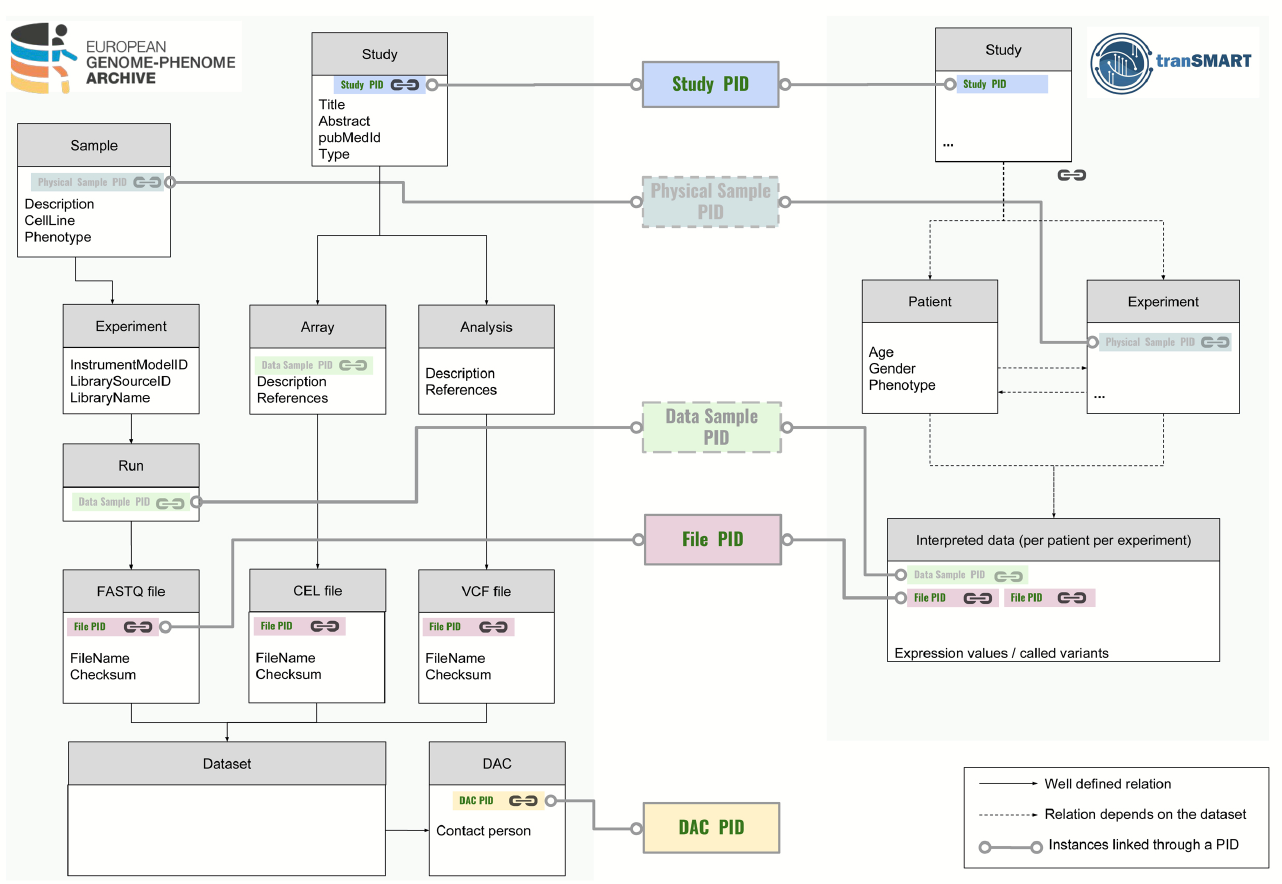
Figure 5. Suggested usage of persistent identifiers to link concepts between the data models of EGA and tranSMART. The data model of EGA differs much from that of tranSMART; for example, a tranSMART experiment has a different conceptual meaning compared to the EGA ‘experiment’, which is one of the four ‘processing’ objects at EGA (experiment, run, analysis, and array). A few well-defined entities with persistent identifiers (PIDs) are essential to achieving the interoperability between the systems. From this implementation study, Study PID, File PID and DAC PID are thought to be essential for systematic mapping for a stable ecosystem allowing to reuse data. Moreover, from a TraIT perspective, stable identifier types that describe the physical sample (Physical Sample PID) and the raw data associated with such a sample (Data Sample PID) are desirable. For the first concept, the BioSample definition could be used, for the second concept, it is clear that there is a need for a well-defined aggregate identifier above the file level that covers all raw output data from a single experiment on a single sample. Ongoing studies aim to generate a well-defined level for these needs, which are also consistent with GA4GH 29 metadata model